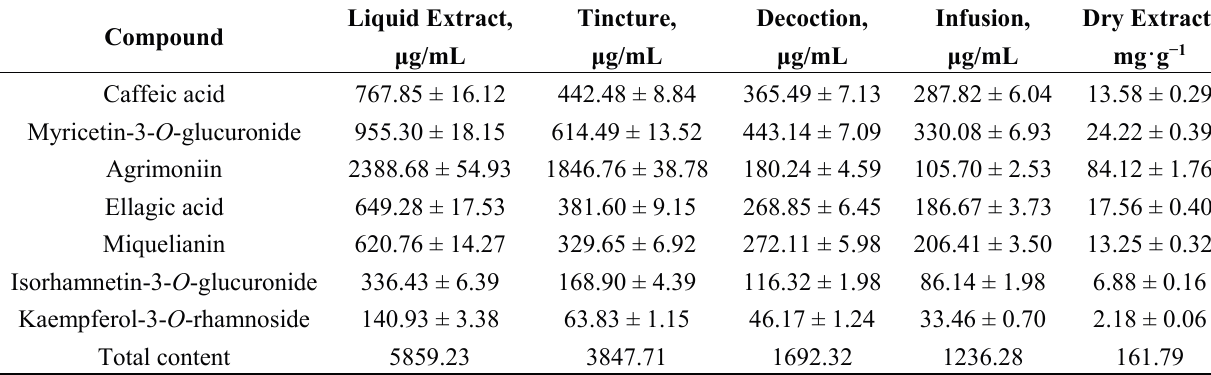
Table 8. Content of seven compounds in P. anserina